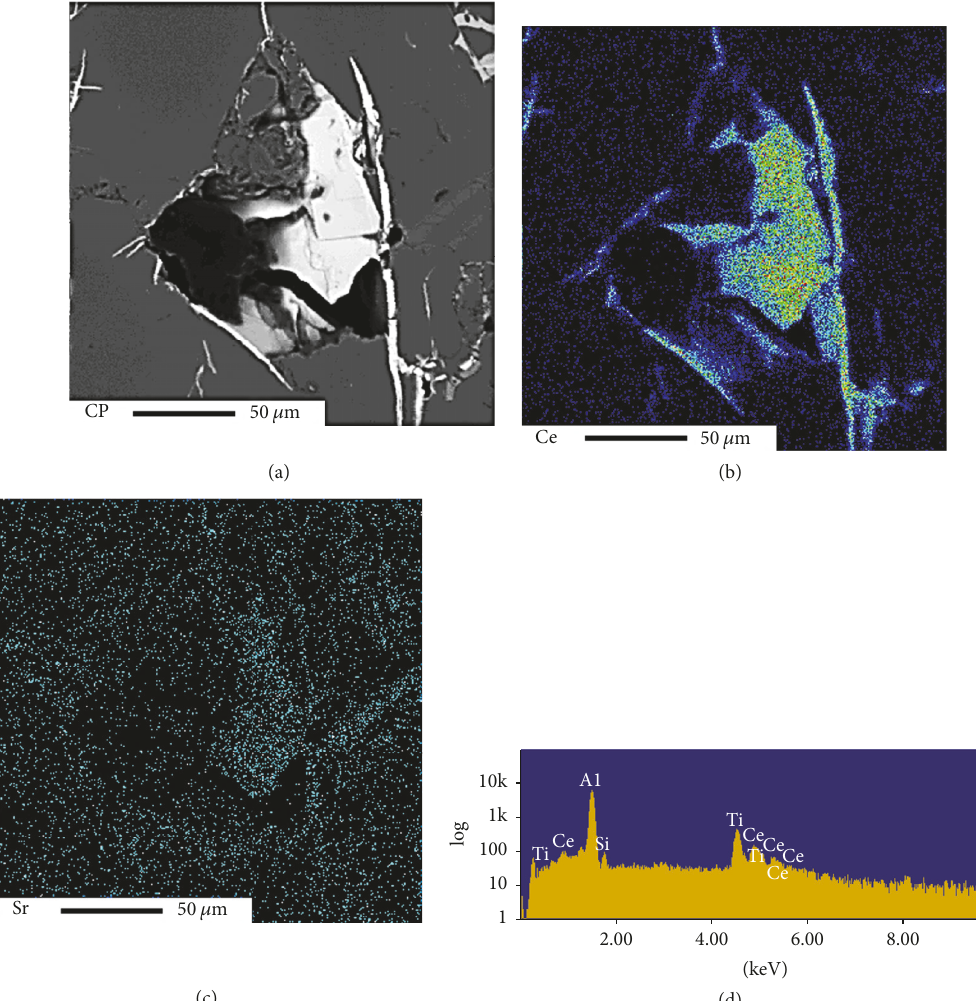
Figure 12: (a) Backscattered electron image showing Ce-rich platelets in Sr-modified A356 alloy containing 1.025% wt.% Ce and elemental distribution of (b) Ce, (c) Sr, and (d) EDS spectrum corresponding to